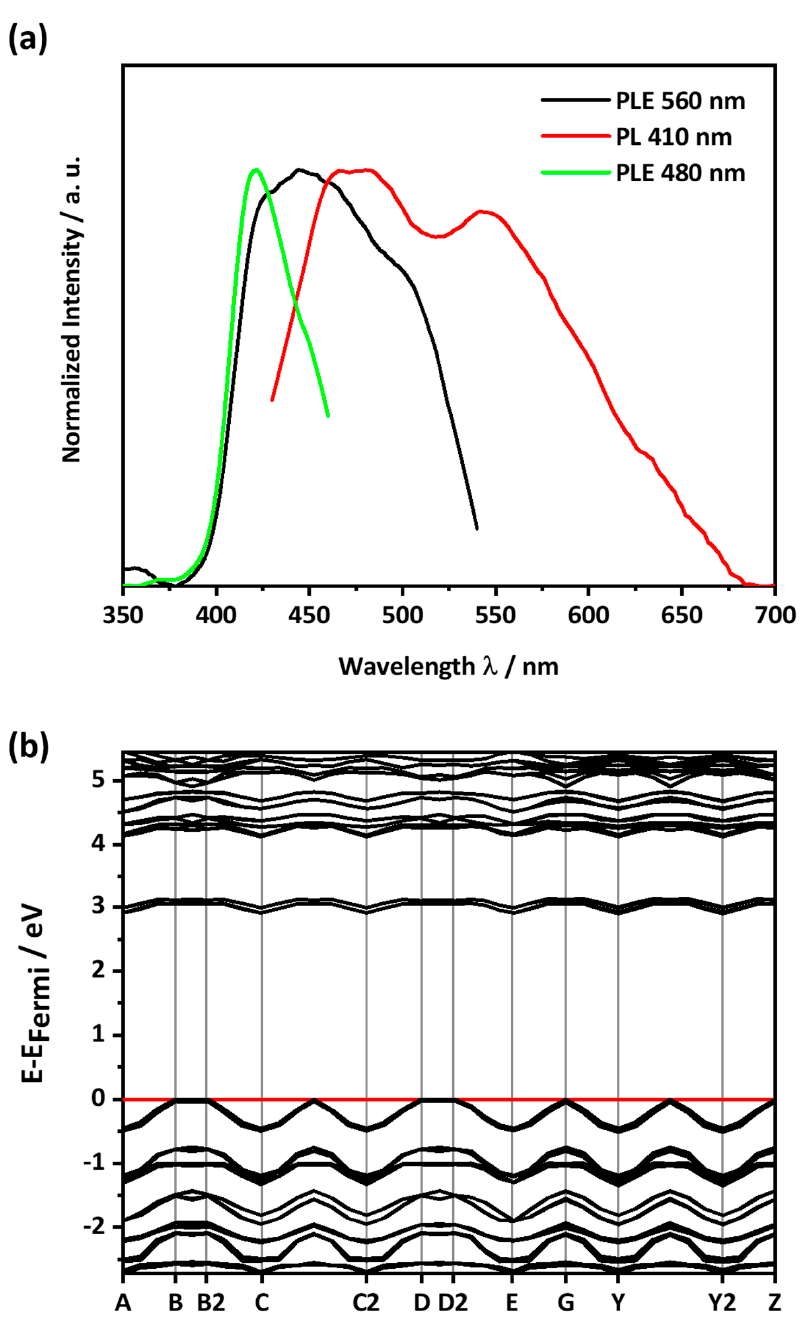
Figure 3. ( a ) Solid-state photoluminescence (PL, red line) and photoluminescence excitation (PLE, green line and black line) spectra of BCPIN. ( b ) Simulated band structure of BCPIN as obtained at HSE06 level of theory.